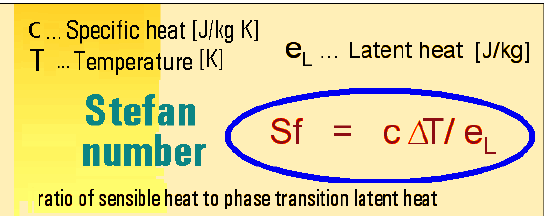
Fig. 15. Stefan number Sf is expected to be the governing dimensionless parameter of prime importance in processing the experimental data obtained for the melting and solidification studies in the capsule